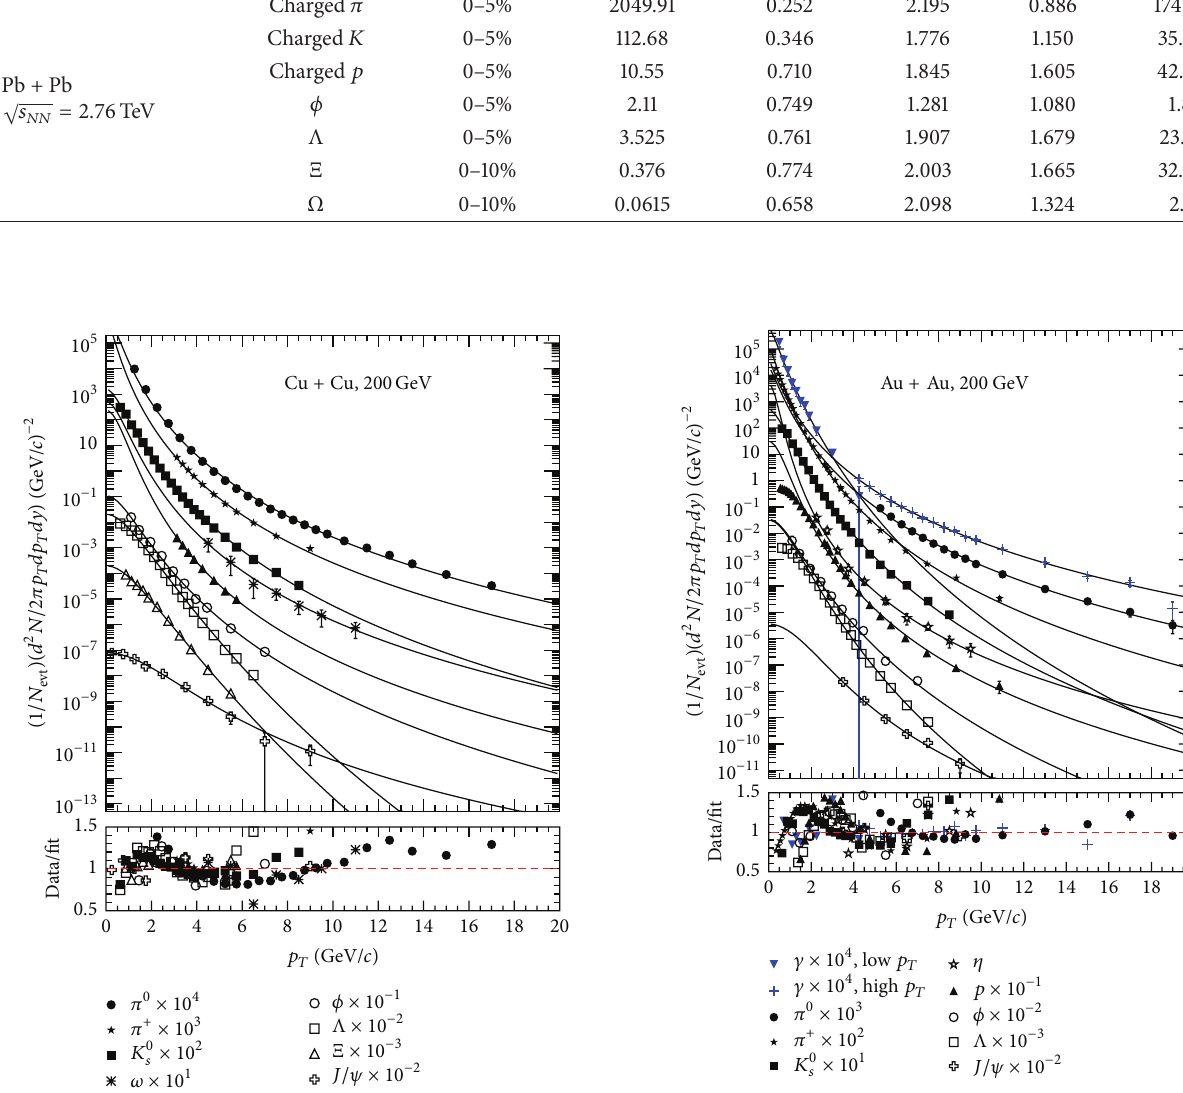
Pb + Pb √𝑠 = 2 . 76 TeV 𝑁𝑁